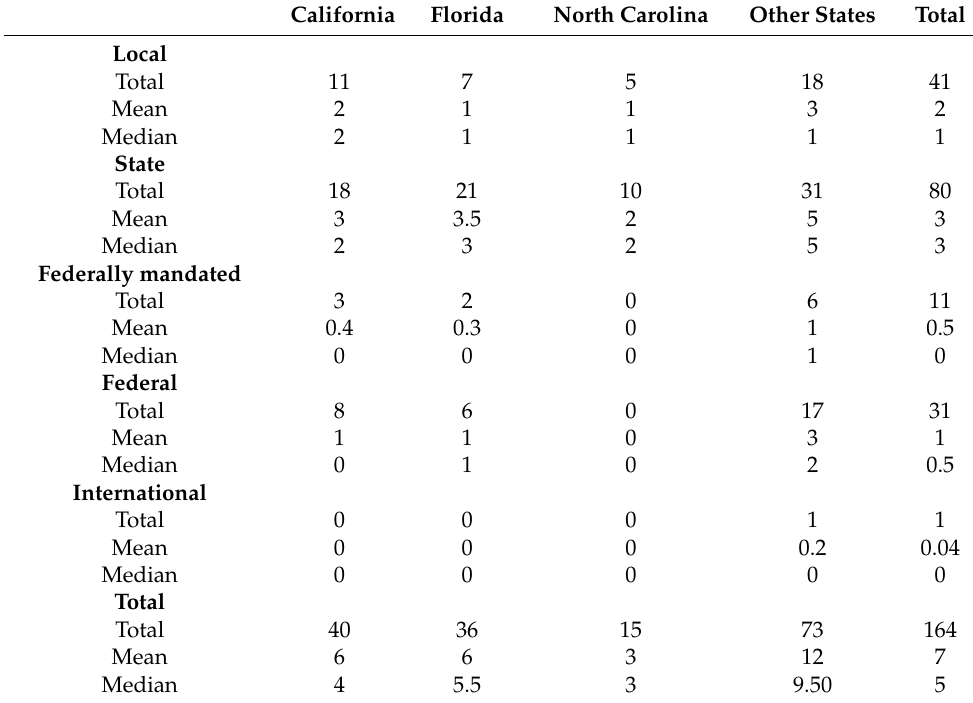
Table 5. Number of regulatory filings a (includes all applications